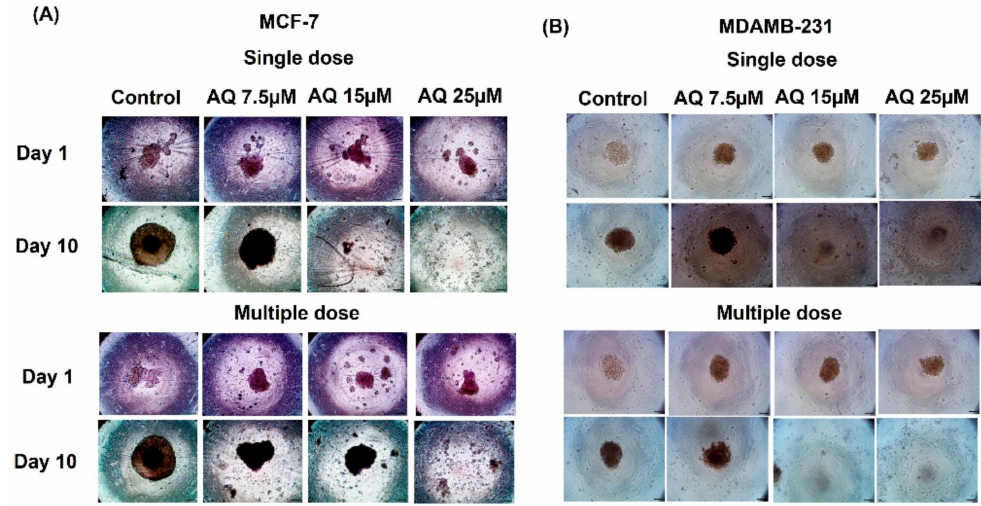
Figure 4. 3D Spheroid study: ( A ) Representative spheroid images of MCF-7 cell line (Single dose and Multiple dose) ( B ) Representative spheroid images of MDAMB-231 cell line (Single dose and Multiple